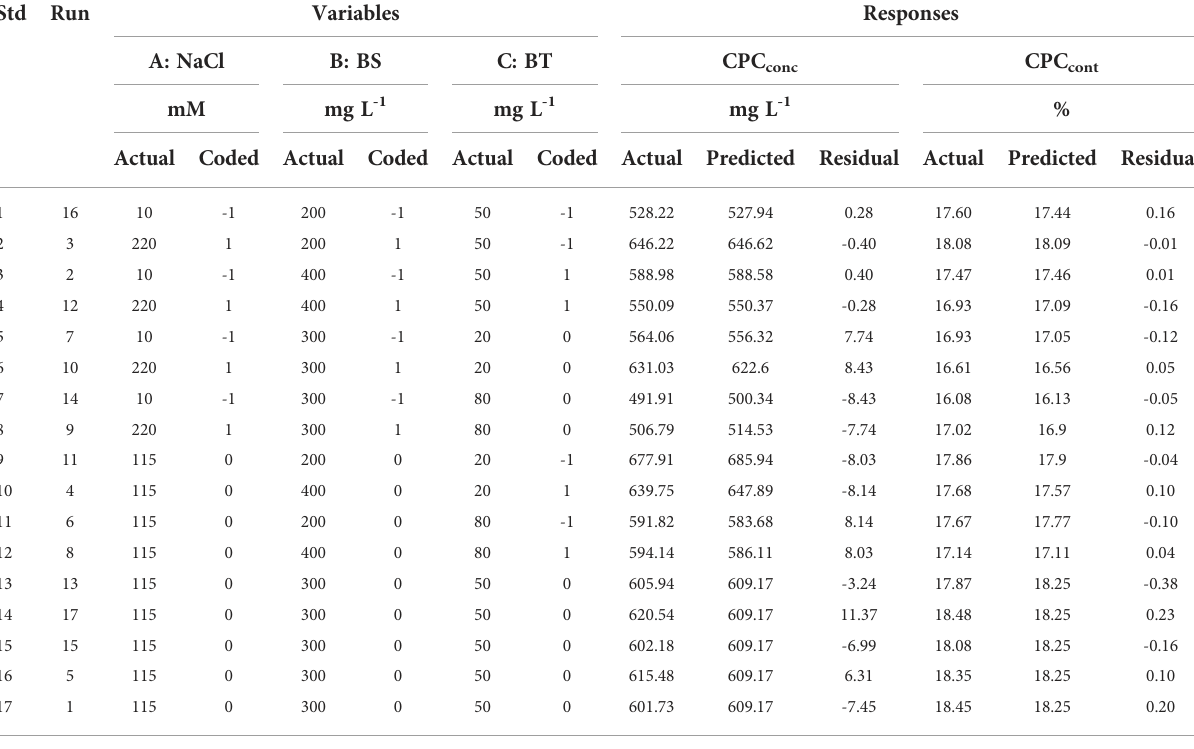
TABLE 2 Experimental data and predicted value based on established models of CPC conc and CPC cont. . Std Run